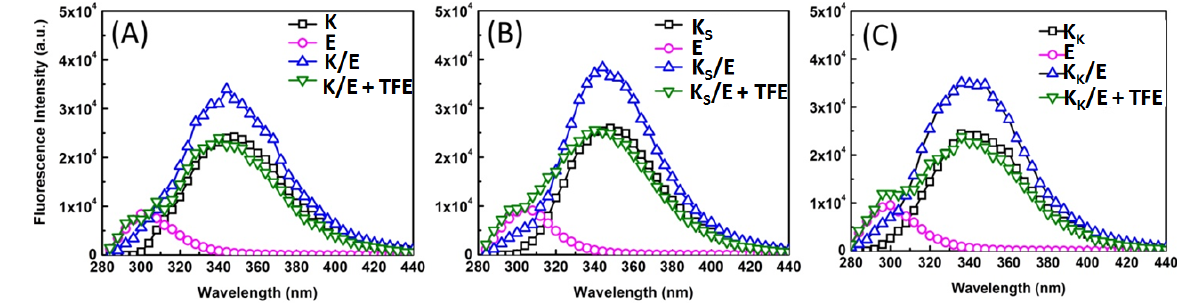
Figure 3: Fluorescence emission spectra (extension at 275 nm) of fluorescent labeled peptides 50 uM in either pH=7.4 PBS buffer or 1:1 TFE/ PBS solution on 25 o C. For instance, (A) shows fluorescence signal of K’ (black), E’ (purple) respectively in PBS buffer, and the signal when they are 1:1 forming into coiled coil complexes (blue). Green signal indicates coiled coil disassociation via 50% TFE addition. (B) and (C) shows K ’ interaction with E’ respectively. ’ and K K S